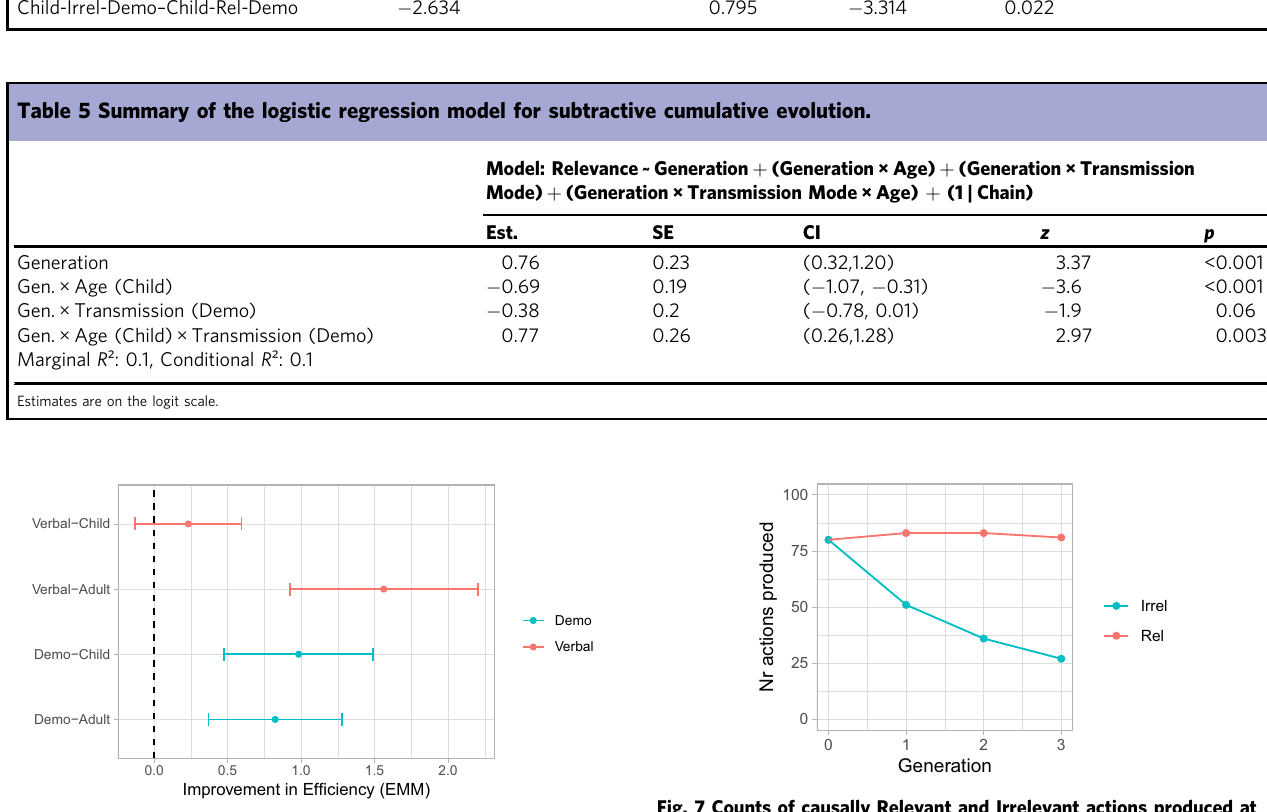
Fig. 6 Estimated marginal means with 95% CIs of Improvement in Ef fi ciency (or loss of Irrelevant actions over Generations) in the different conditions of participant Age by Transmission condition. All pairwise contrasts are in SM.8.